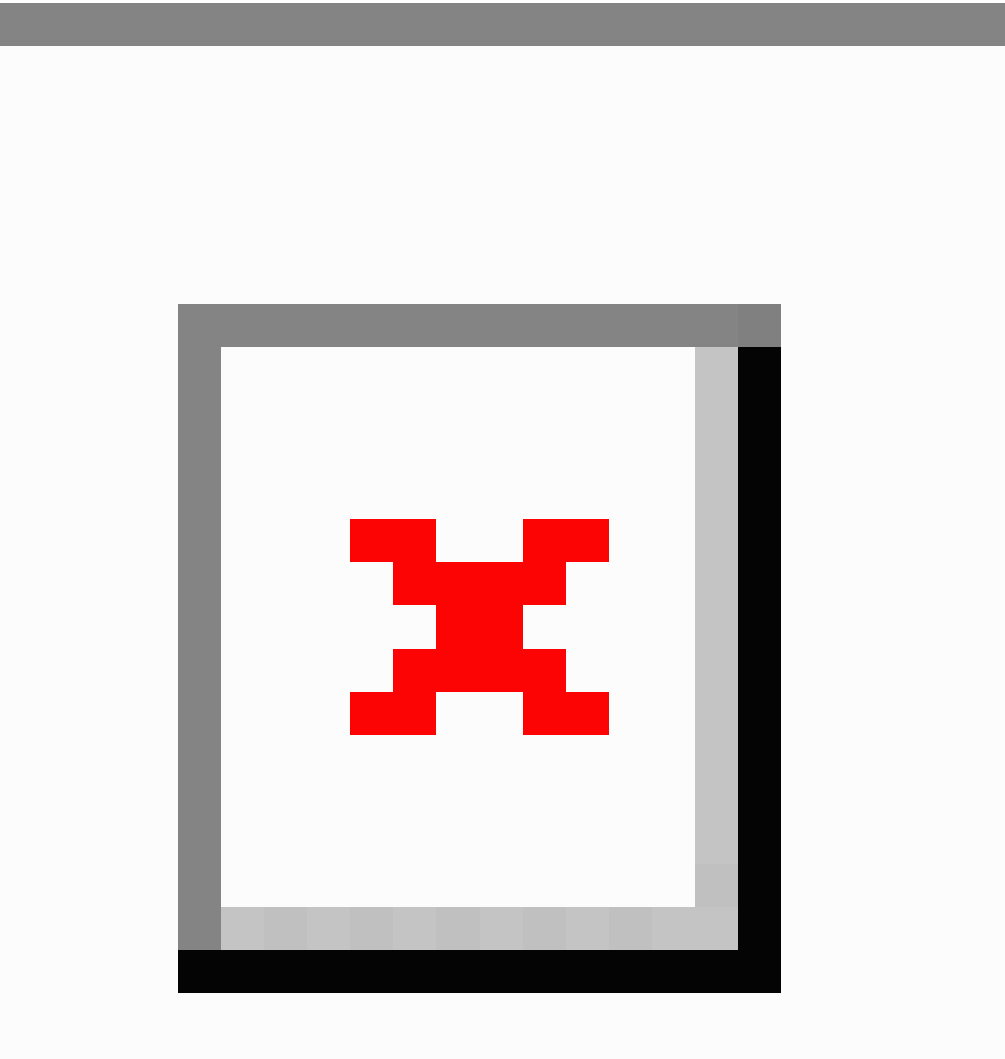
Figure 2. The reported human H7N9 cases and the daily posted and forwarded number of H7N9 discussion trends on Sina microblog in China from March 31 to April 24,